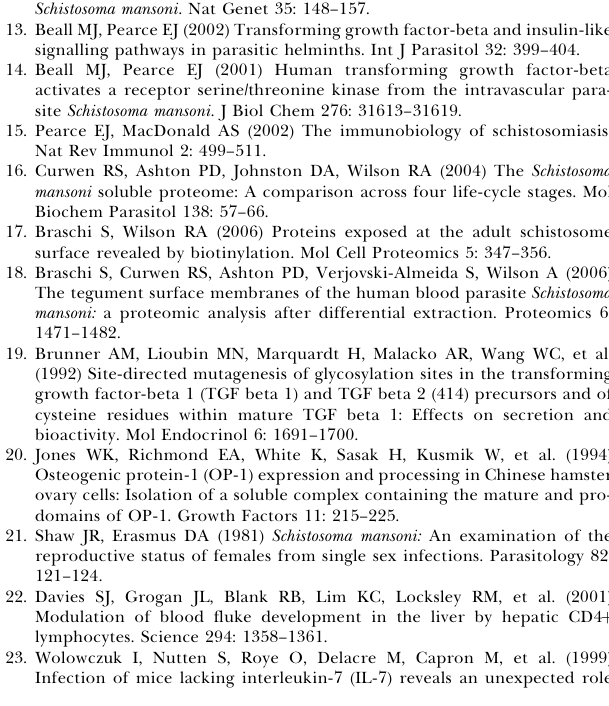
Figure S1. SmInAct Transcript Is Not Detectable in SmInAct dsRNA– Treated Eggs